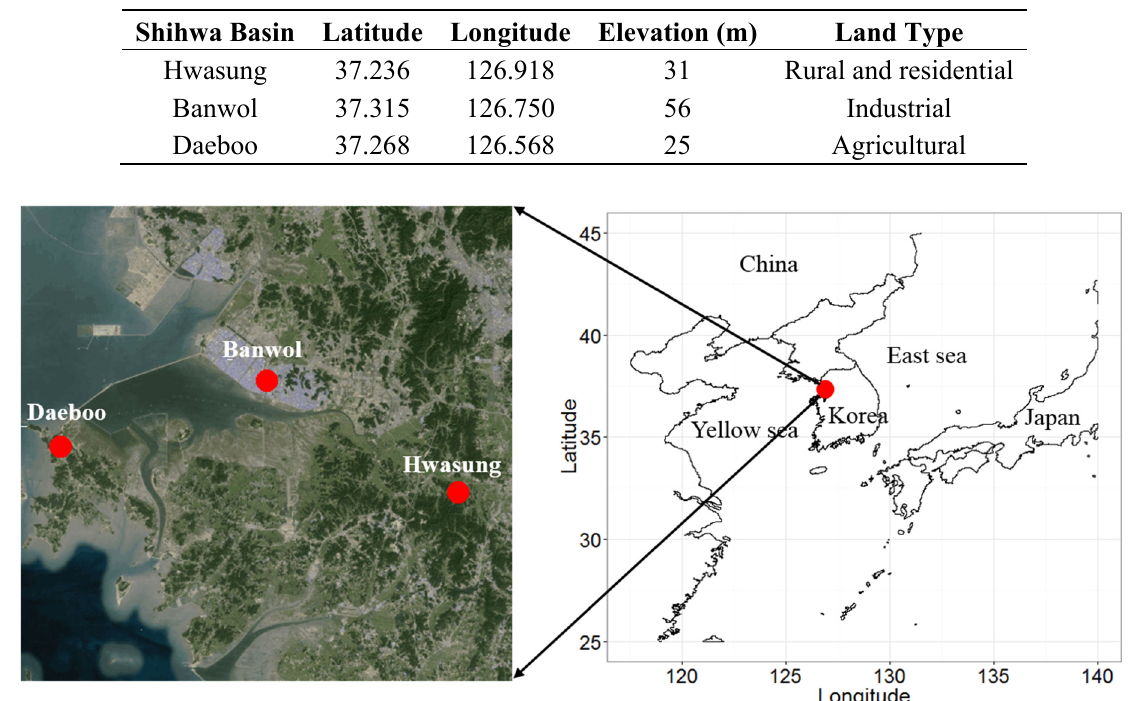
Figure 1. Locations of the study area and sampling